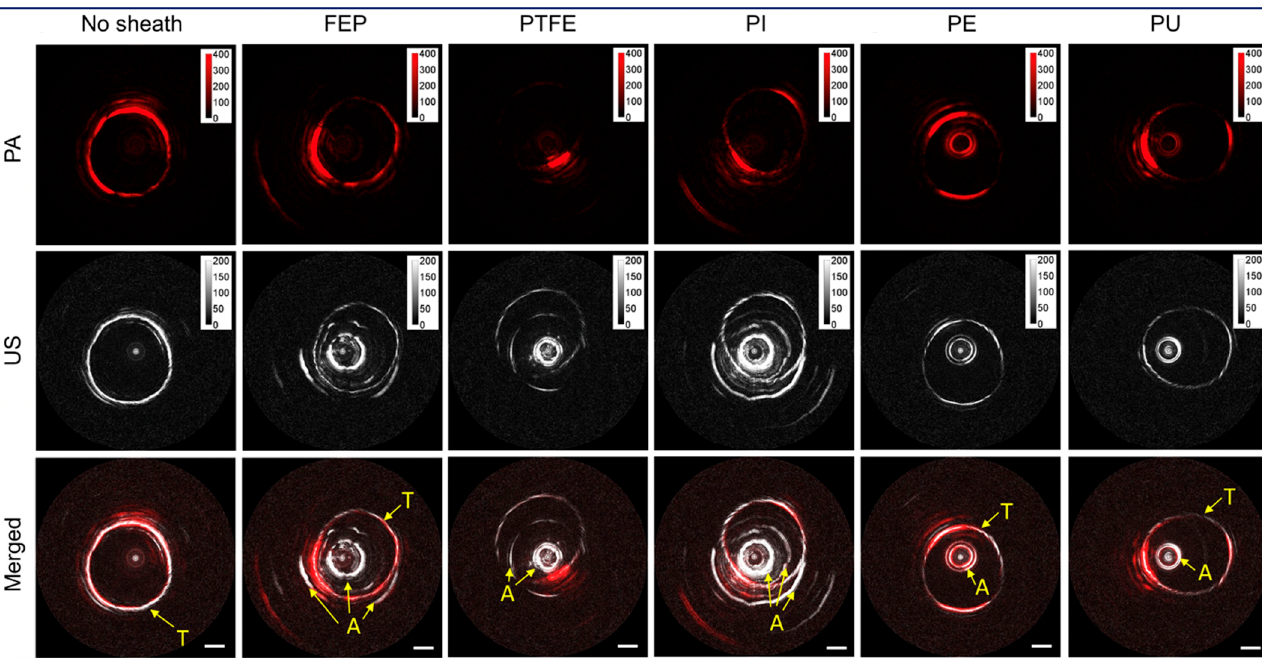
Figure 5. Sheath performance. Adapted from [89]. PE, polyethylene. FEP, fluorinated ethylene propylene. PTFE, polytetrafluoroethylene. PI, polyimide. PU, polyurethane. A, induced artifact from sheath. T, imaging target.